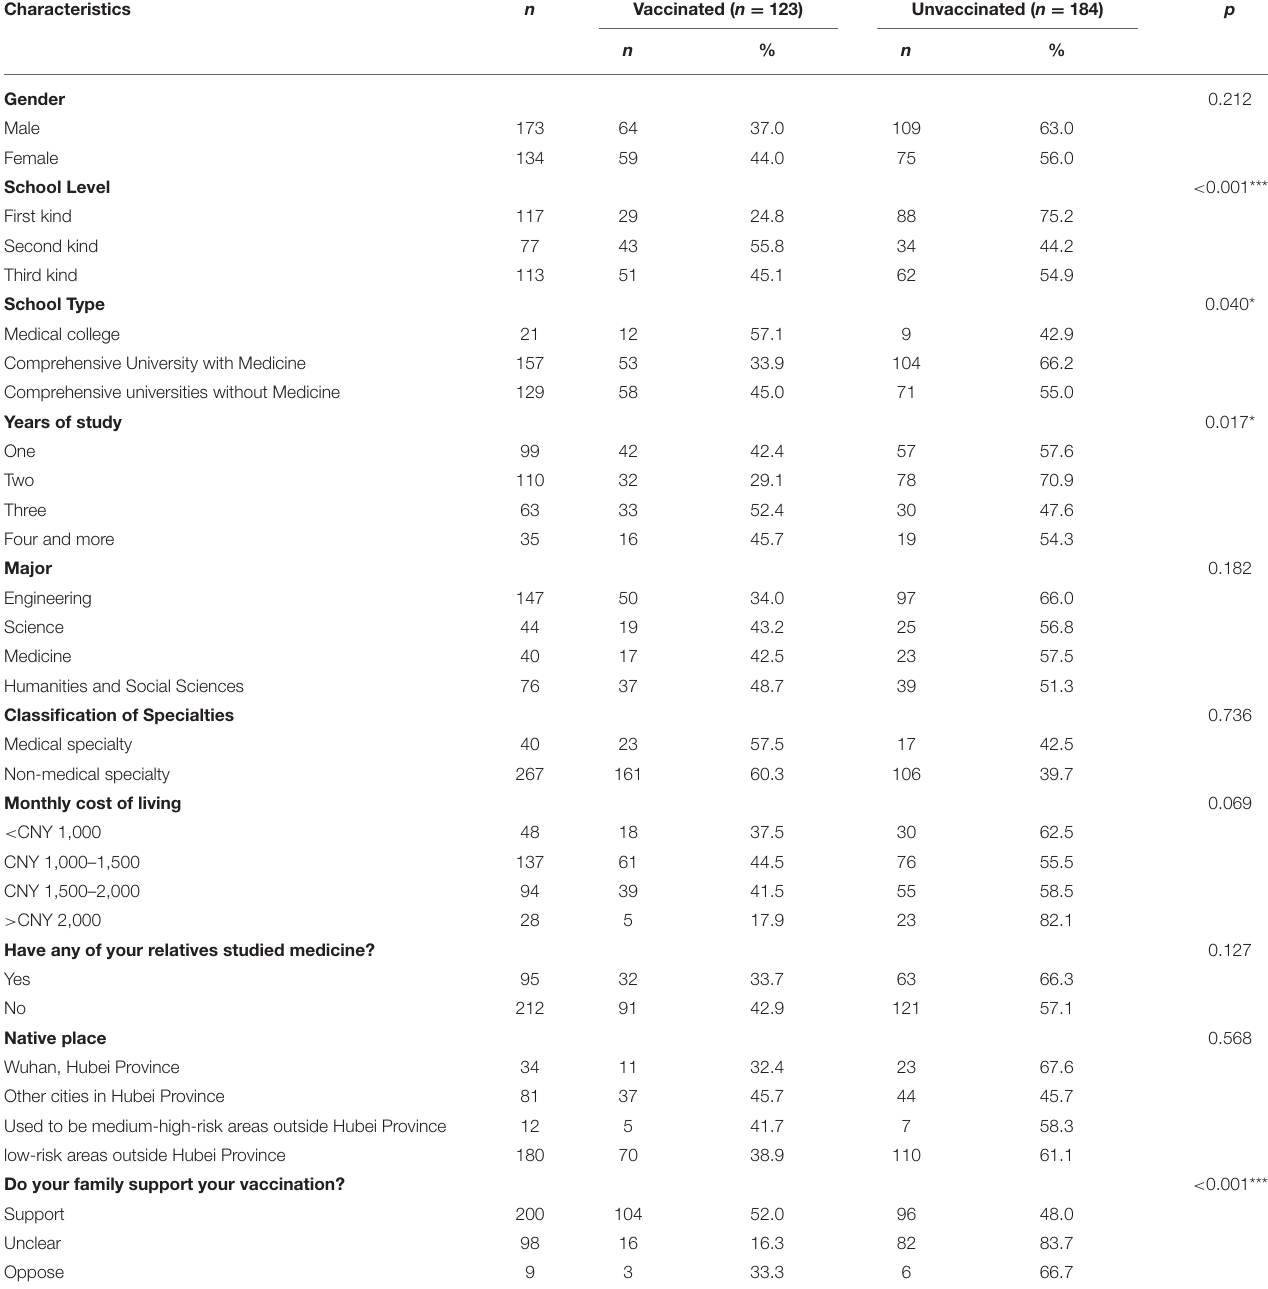
TABLE 2 | Comparison of vaccination status among the COVID-19 vaccine hesitators with different characteristics. Characteristics n Vaccinated ( n =